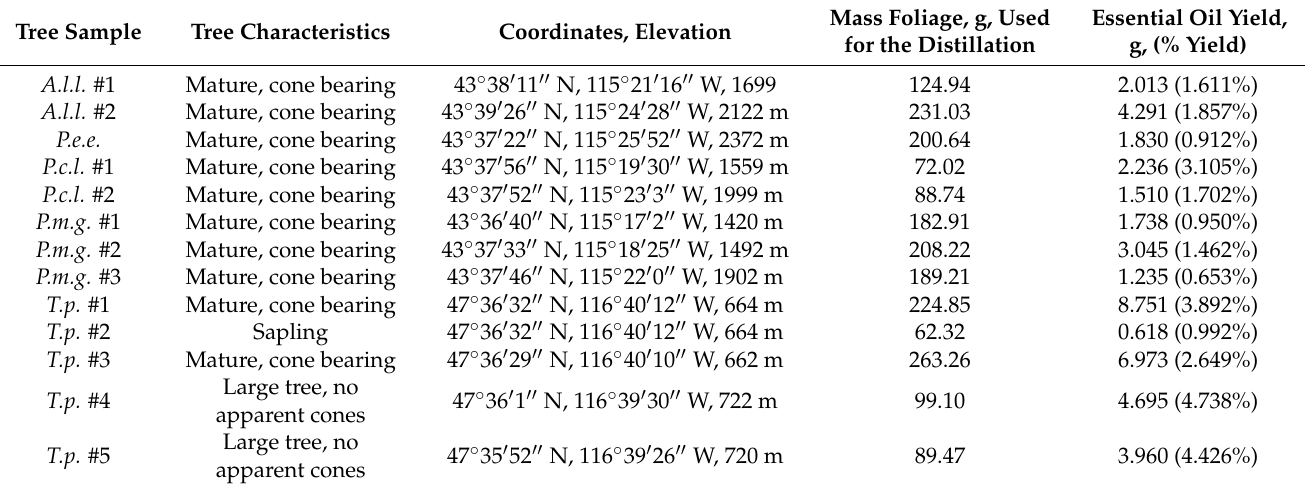
Table 7. Collection and hydrodistillation details of Abies lasiocarpa var. lasiocarpa ( A.l.l. ) Picea engelmannii subsp. engelmannii ( P.e.e. ), Pinus contorta subsp. latifolia ( P.c.l. ), Pseudotsuga menziesii